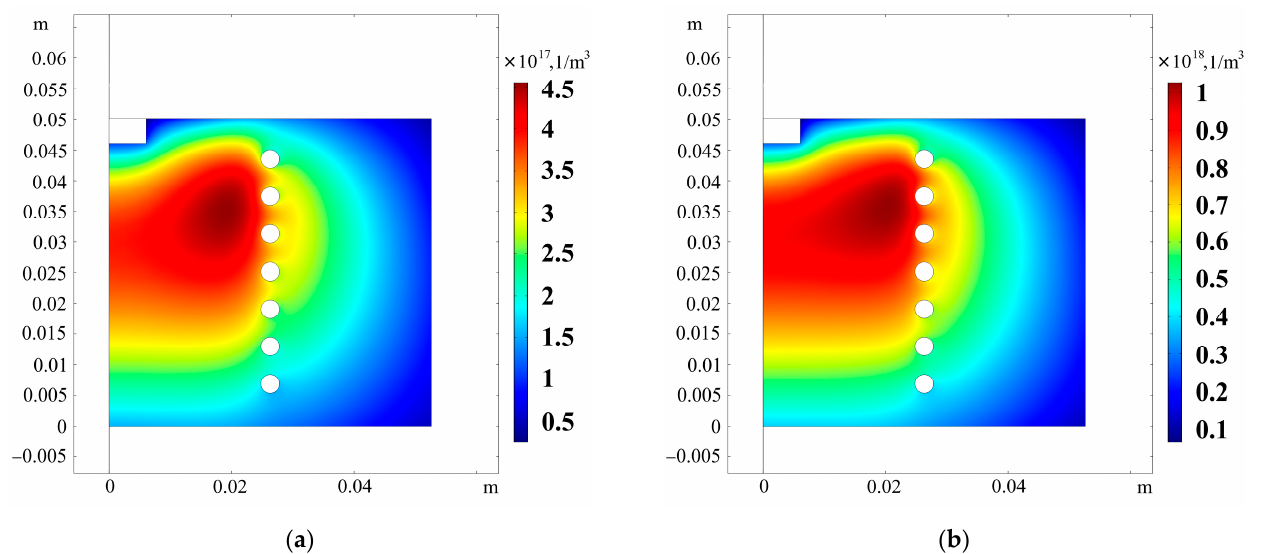
Figure 8. Two-dimensional distribution of charged particle density over the DC volume in the case of using an internal antenna with cylindrical arrangement of turns: ( a ) xenon flow rate of 0.5 mg/s, RF power of 86 W, extracted ion current of